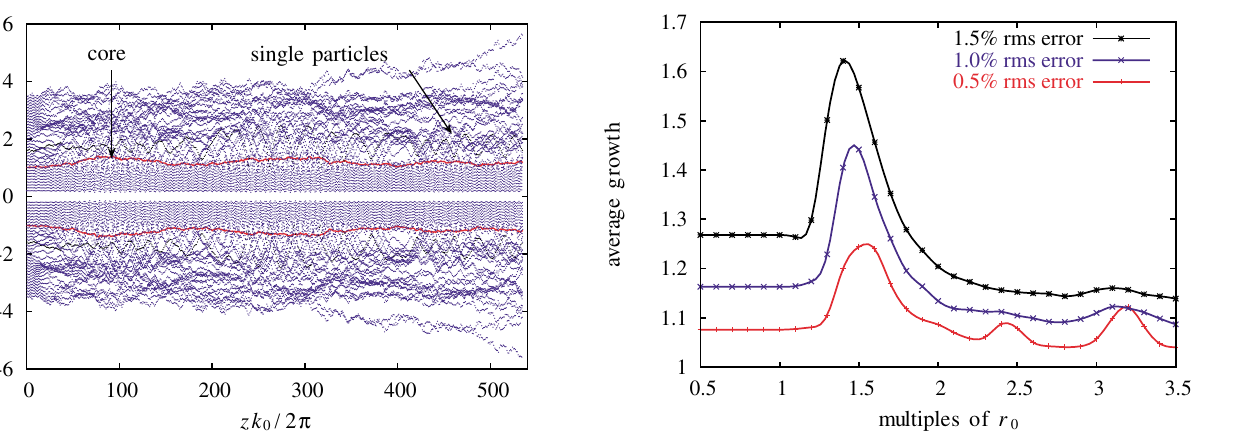
FIG. 5. (Color) Maximum envelope values for core and single particle oscillations in the case of a matched beam with 1% rms statistical focusing gradient errors 0 : 2 (cid:11) (cid:11) 3 : 5 , (cid:18) (cid:3) 0 : 8 x (cid:4) 0 (cid:5) =r 0